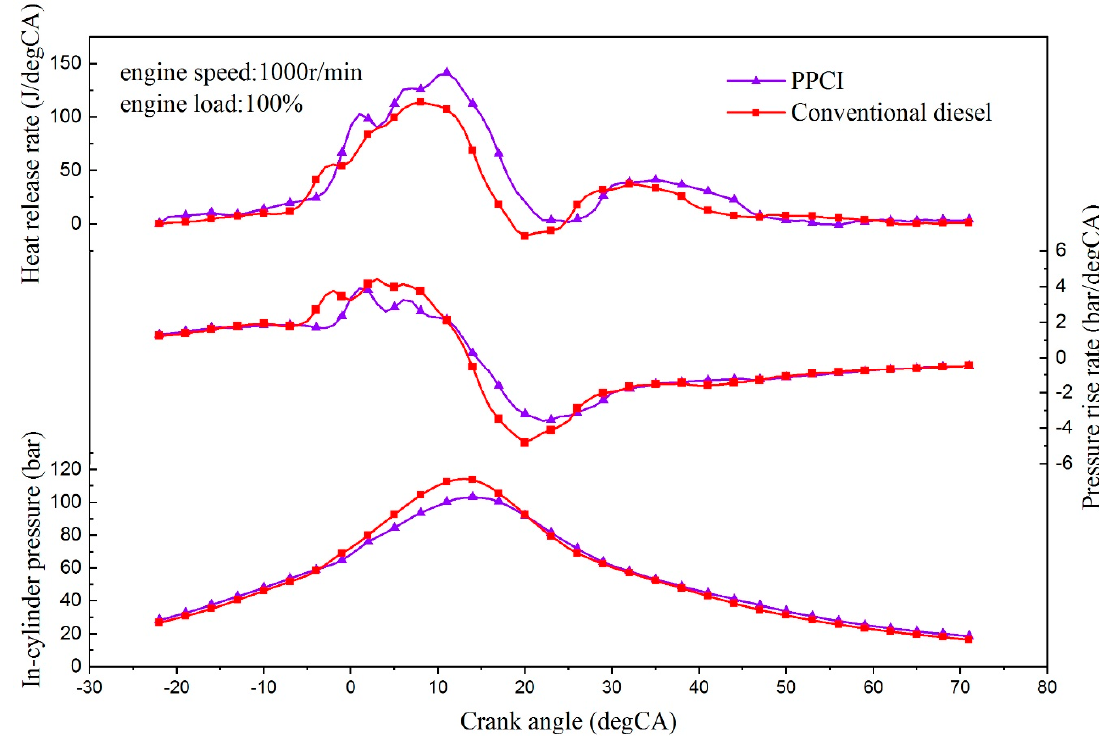
Figure 2. Combustion characteristic curves of conventional diesel combustion and partially premixed compression ignition (PPCI).